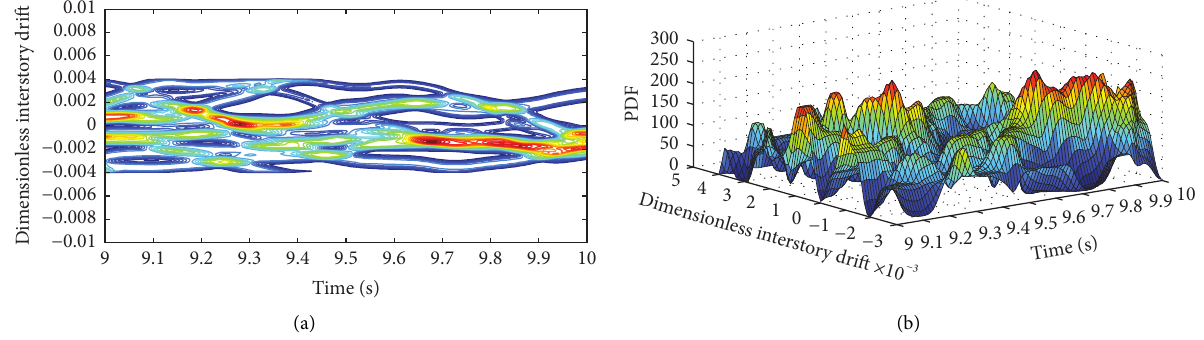
Figure 11: Probabilistic information of the dimensionless interstory drift for 10-story building under XYZ directions excitation. (a) Contour of PDF surface. (b) PDF evolution